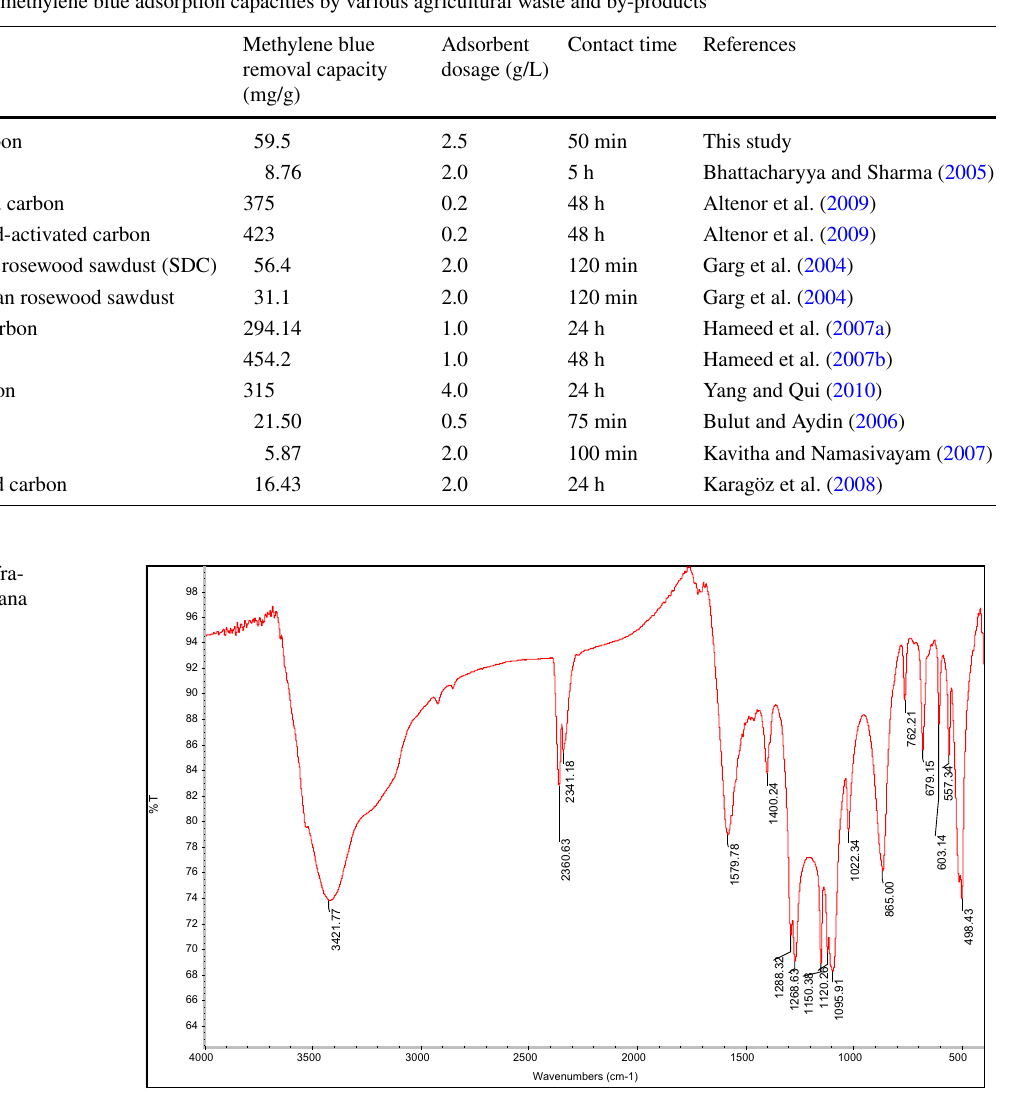
Fig. 3a, the maximum desirability lies near maximum tem- perature or maximum time; in Fig. 3b the maximum desir- ability lies near low activating agent concentration and extended uniformly over the time axis. This implies that at low concentration of H PO (1.5 mol/L) and minimum 3 4 time of activation (50 min), desirable activated carbon for efficient methylene blue removal capacity (64.66 mg/g) can be achieved. In Fig. 3c, the desirability shifted towards higher temperature of activation. At a low temperature not make any difference at fixed activation time (85 min.);